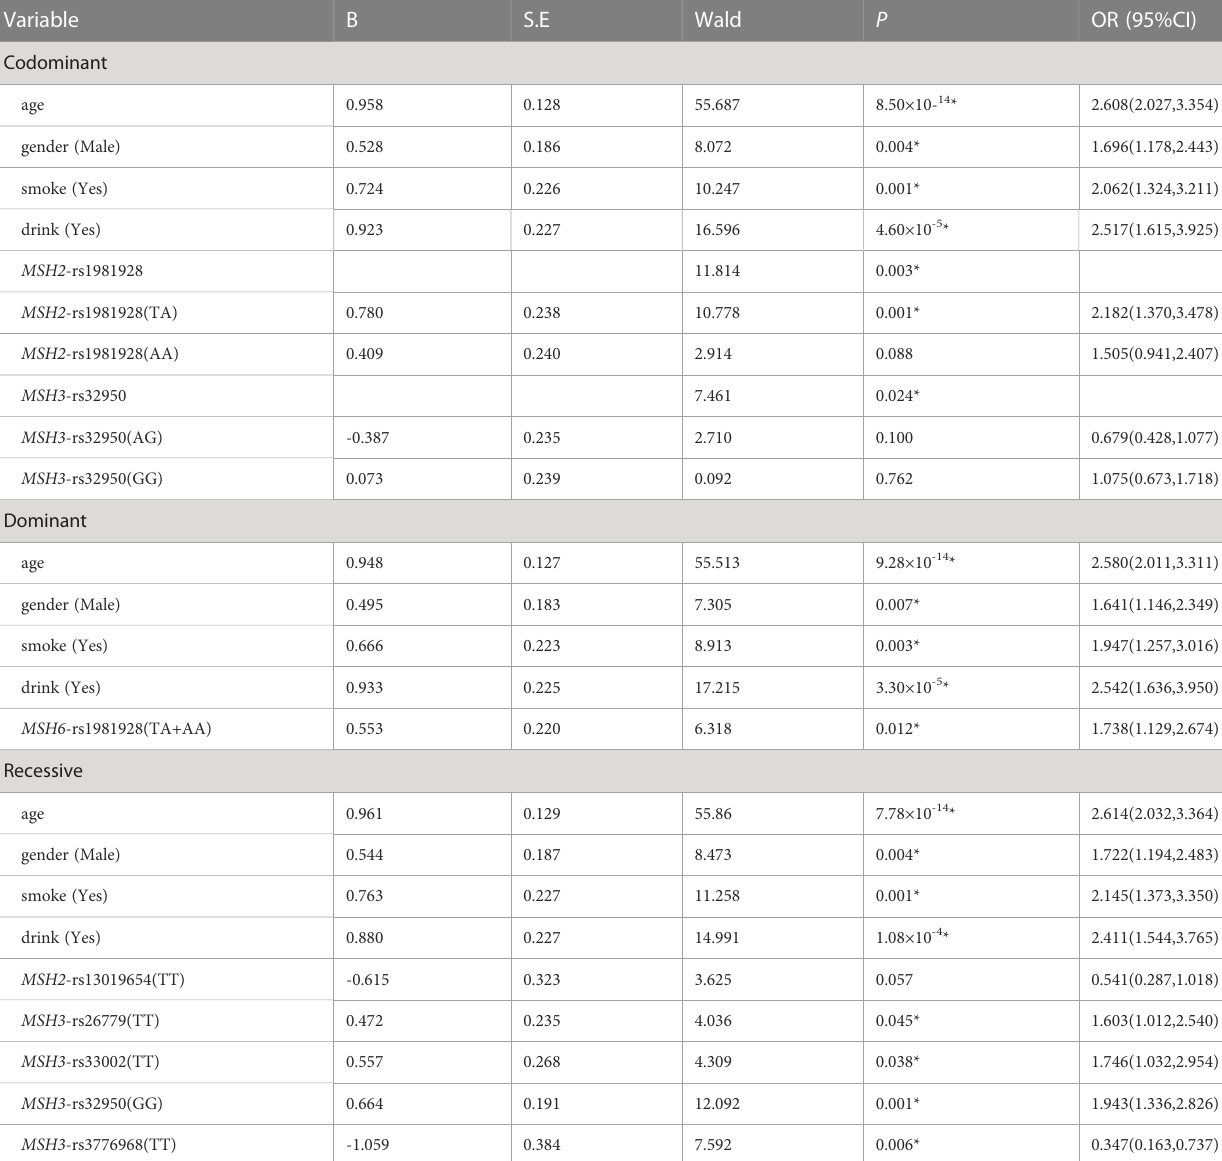
TABLE 5 Multiple logistic regression analysis of predictive factors for hepatocellular carcinoma between SC and HCC in three models.